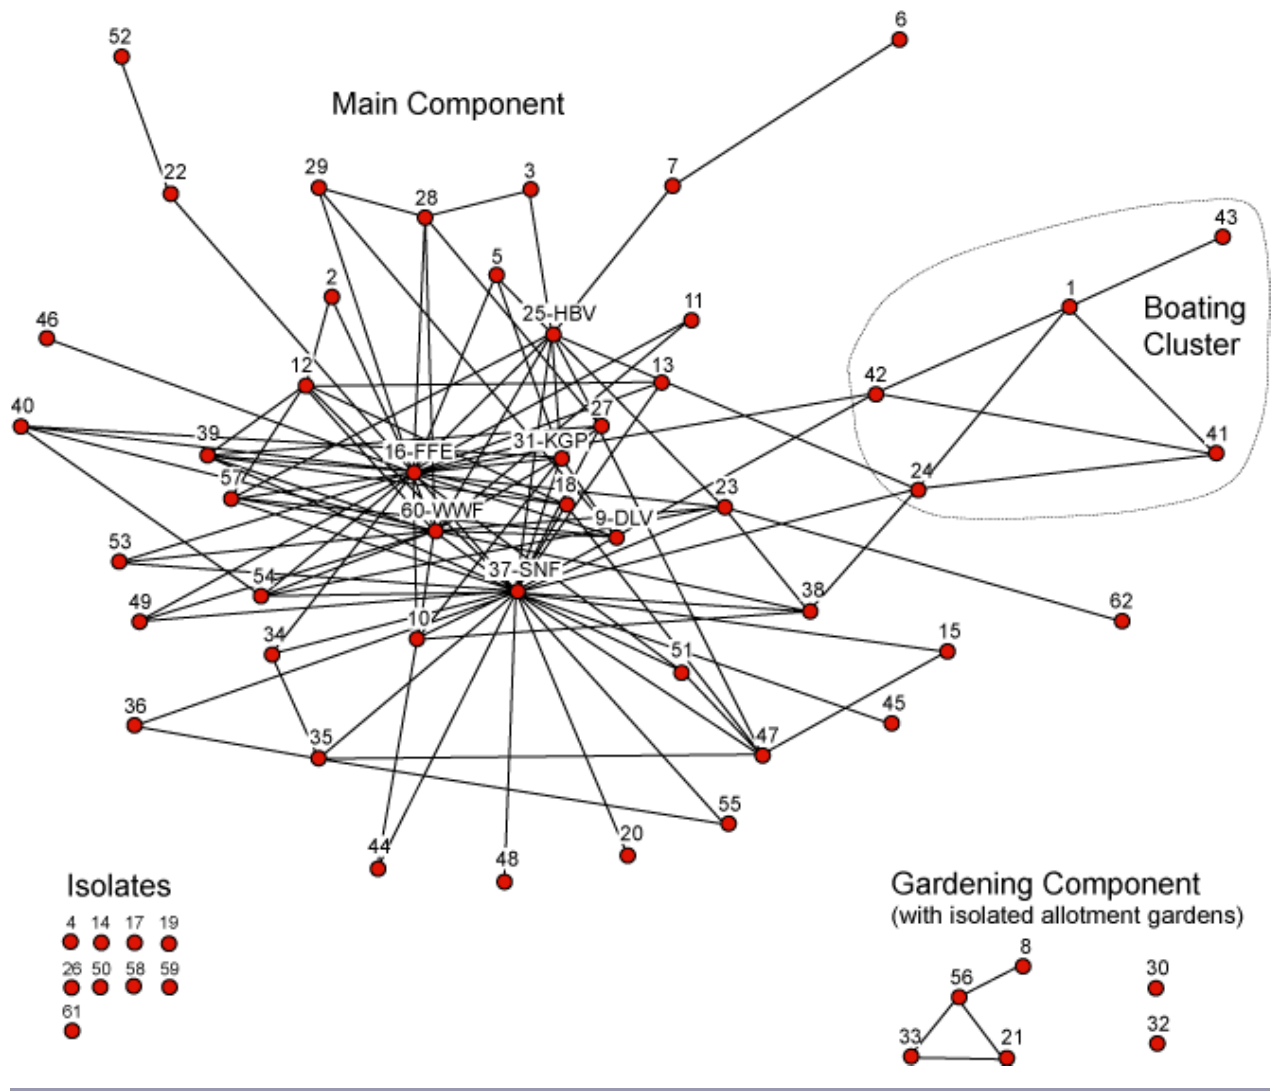
Fig. 3. The social network of the Ecopark movement consists of 62 organizations perceived as active in the protection of the National Urban Park by at least two respondents. They are divided in a Main Component (47 nodes), Gardening Component (4), and several unconnected Isolates (11). Also indicated is the Boating Cluster. The network is generally sparse and of low density; of the 2162 possible links, only 190 were realized in the valued network, whereas 119 were in the symmetrical network. Distances were nonetheless short, with an average of 2.33, and a maximum distance of 5 in the symmetrical network (of the Main